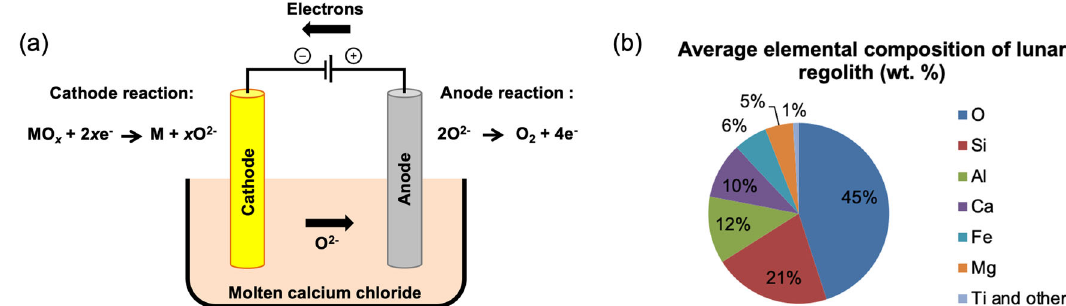
Fig. 3 The FFC-Cambridge process and its potential application on the moon. a The principle behind the FFC-Cambridge process for the electrochemical reduction of metal oxides to give the metals and oxygen. b An approximate average elemental composition (wt. %) of lunar regolith serving as the cathode material.